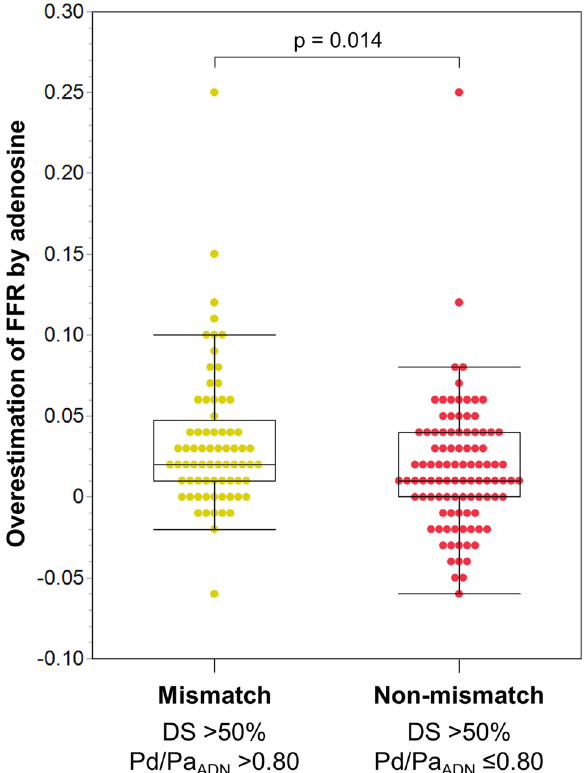
Figure 2. Comparison of overestimation of FFR by adenosine in anatomically significant vessels between the anatomical ‒ functional mismatch and non-mismatch groups. Distributions of overestimation of FFR by adenosine with box-and-whisker plots are shown. The overestimation of FFR by adenosine was defined as Pd/ Pa ADN –Pd/Pa PAP . DS diameter stenosis , Pd/Pa ADN distal-to-aortic pressure ratio associated with adenosine, and Pd/Pa ADN distal-to-aortic pressure ratio associated with papaverine.